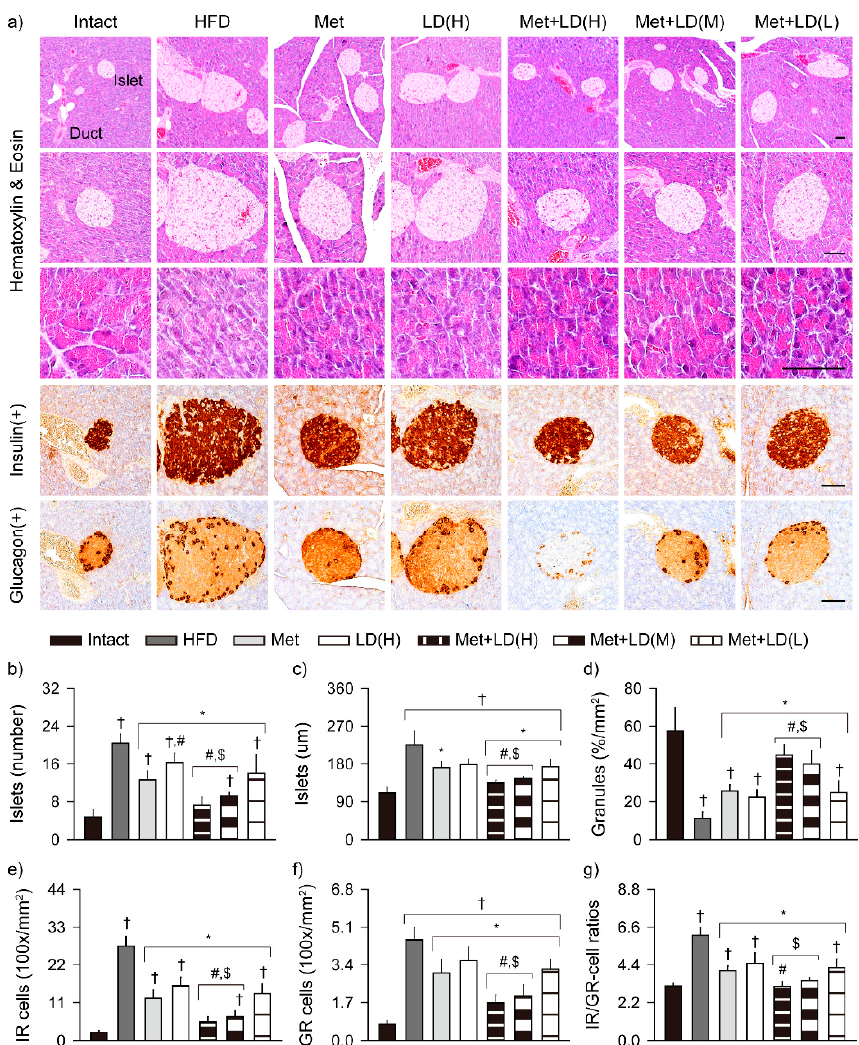
Figure 8. Histopathological improvements in pancreatic lesions. ( a ) Representative images in stains with hematoxylin and eosin and immuno-stains for insulin and glucagon. In hematoxylin and eosin stains, pancreatic islet and exocrine duct (upper) are indicated, and the islets and acinar regions were highly magnified (middle and lower, respectively). Scale bars = 50 μ m. ( b , c ) Numbers and sizes of the islets. ( d ) Acinar areas containing zymogen granules. ( e – g ) Numbers of insulin- (IR) and glucagon-immunoreactive (GR) cells, and ratio of IR to GR cells. Values are represented as the means ± SDs ( n = 8). †, *, #, and $: p < 0.05 vs. the Intact, HFD control (HFD), Met, and LD(H) groups, respectively.